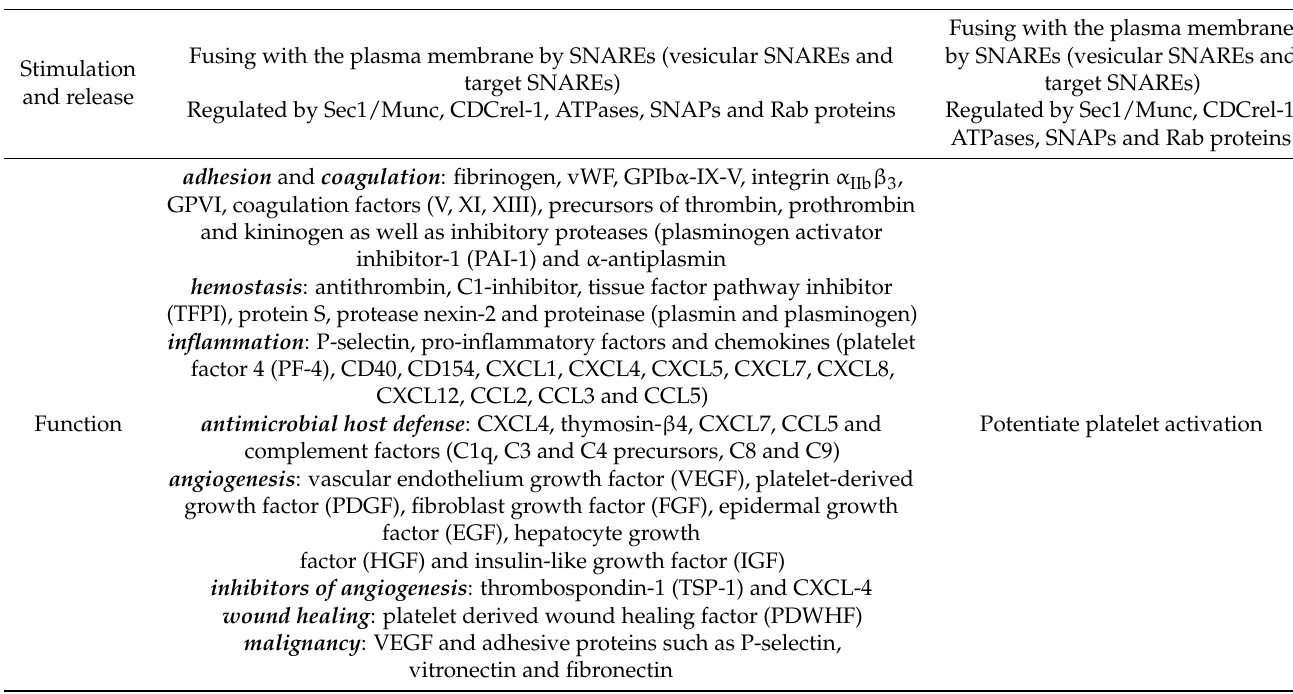
Table 1. Cont. α -Granules Dense Granules